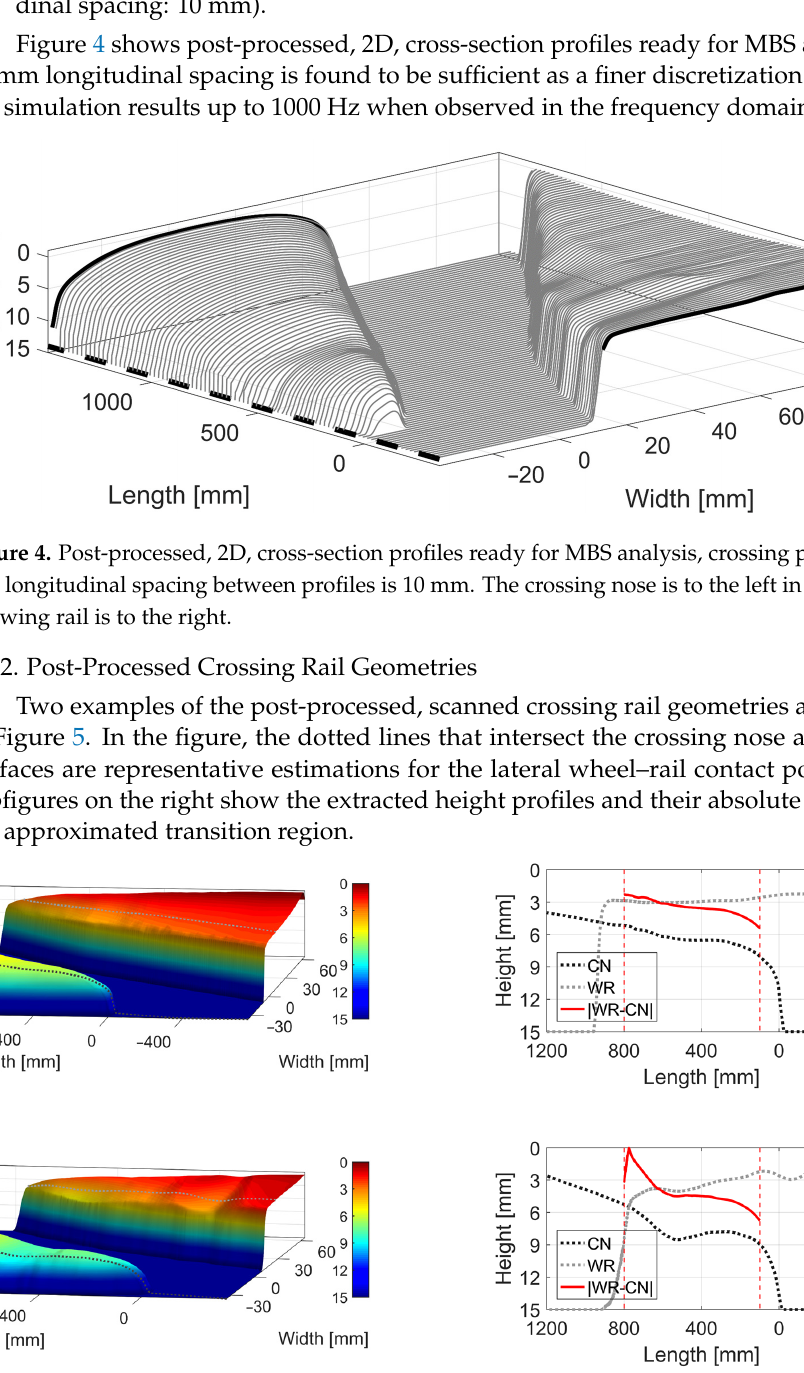
Figure 3. Example of raw 3D geometry scan, crossing panel VAD 131.